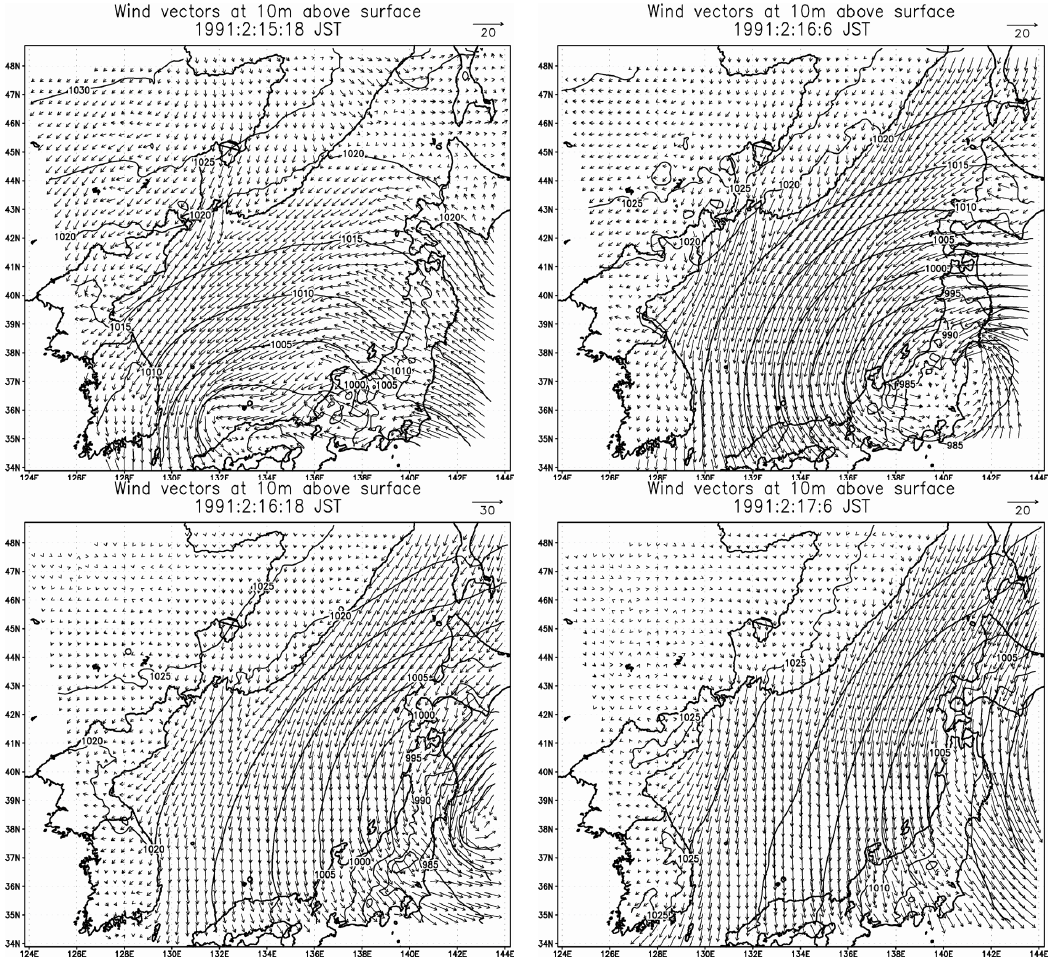
Fig. 8. Calculated wind vectors and isobars from domain 2 for twelve hour increments from 09:00UTC 15 February to 21:00UTC 16 Febru- ary 1991 using JRA-25 for initial and boundary conditions of MM5.